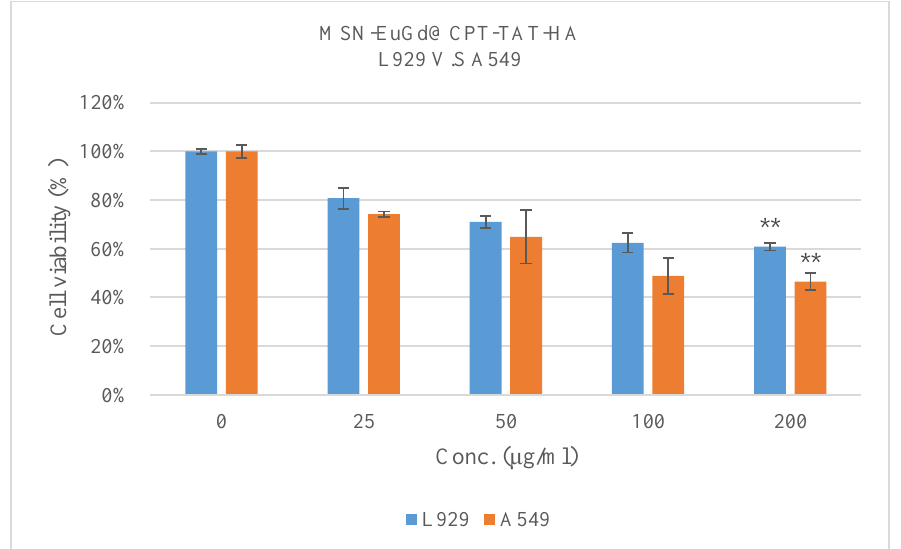
Figure 6. Comparison of cell viability between L929 cells and A549 cells at various concentrations of MSN-EuGd@CPT-TAT-HA, ** p < 0.01.